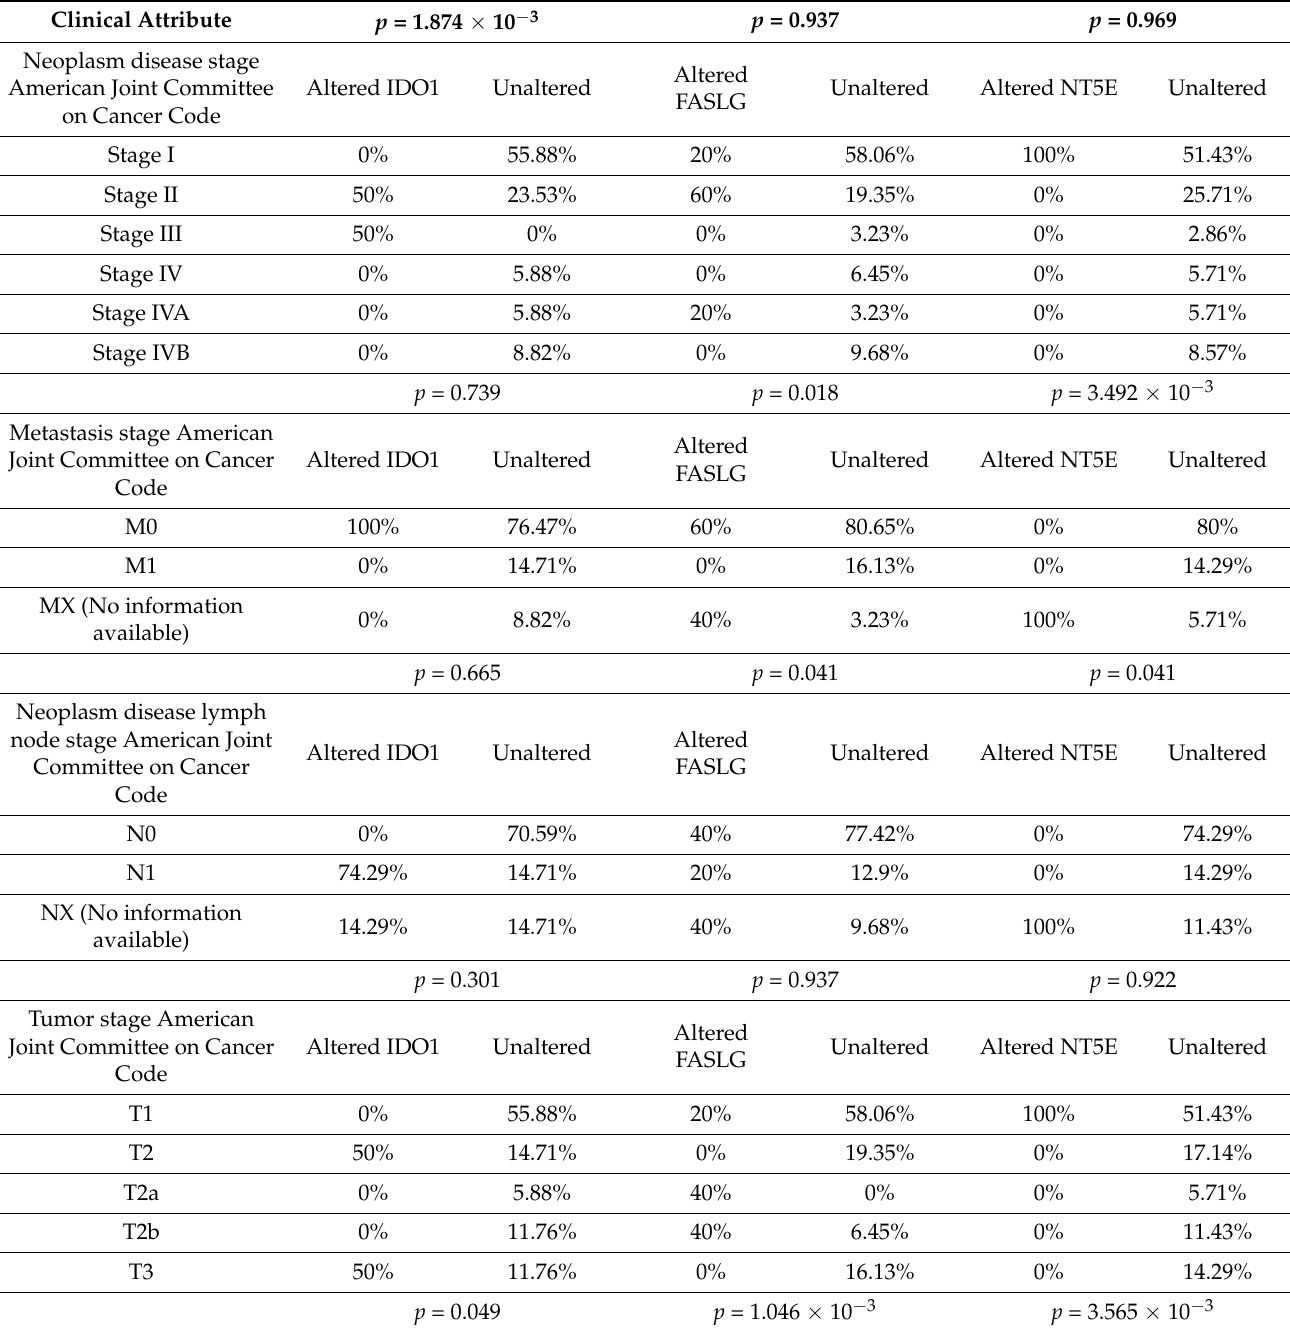
Table 6. Relationship between expression of IDO1, FASLG and NT5E and clinical parameters in CCA patients. Clinical